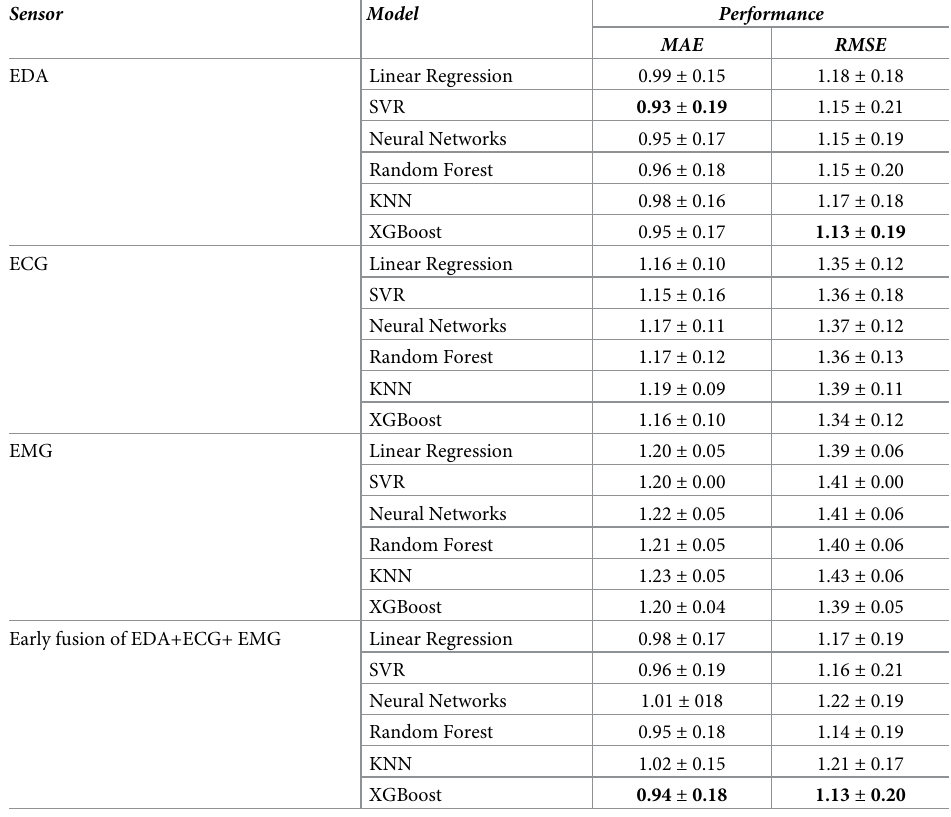
Table 3. Performance values (Mean ± Standard deviation) of generic pain estimation model for different sensor and model combinations across all